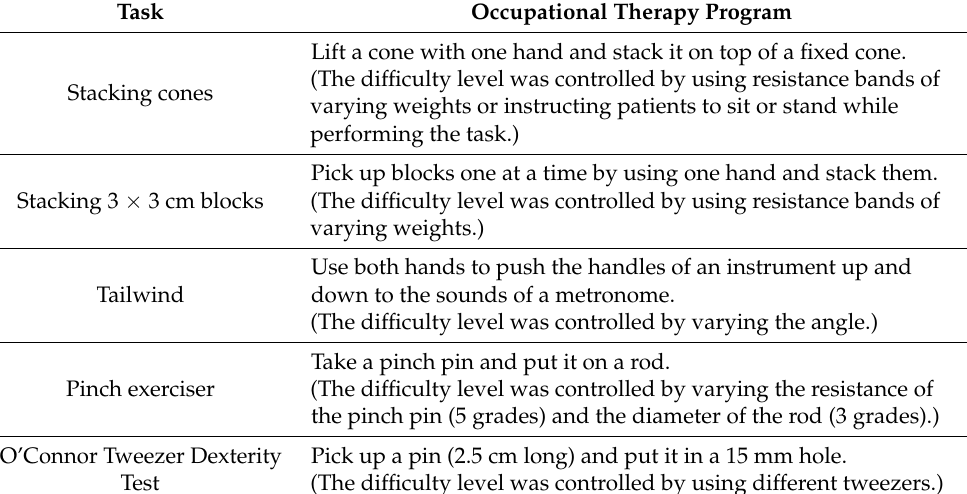
Table 2. Table-top activity training